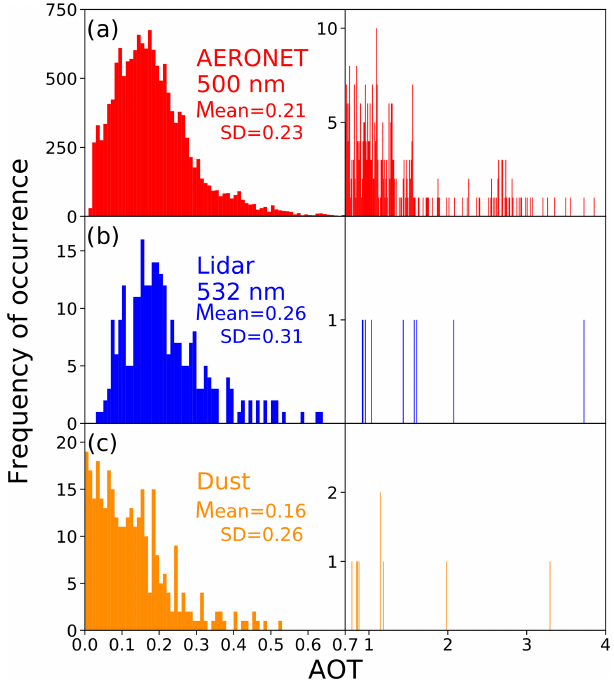
Figure 8. Histograms of (a) AERONET 500nm AOT, (b) lidar- derived 532nm AOT, and (c) lidar-derived dust optical thickness (DOT). DOT is obtained from the height profile of the dust- related backscatter coefficient multiplied by a typical dust lidar ratio of